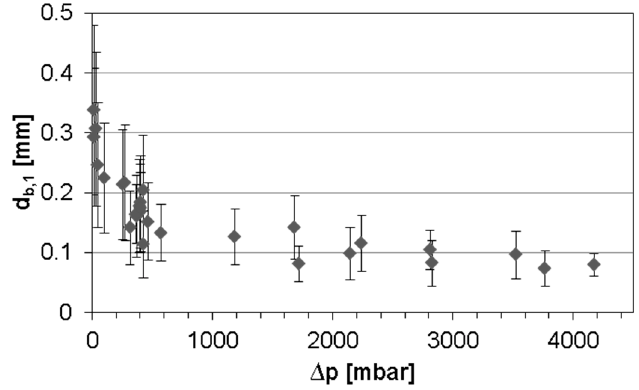
Figure 17. All obtained mean bubble diameters plotted over corresponding pressure drops within the DoE.